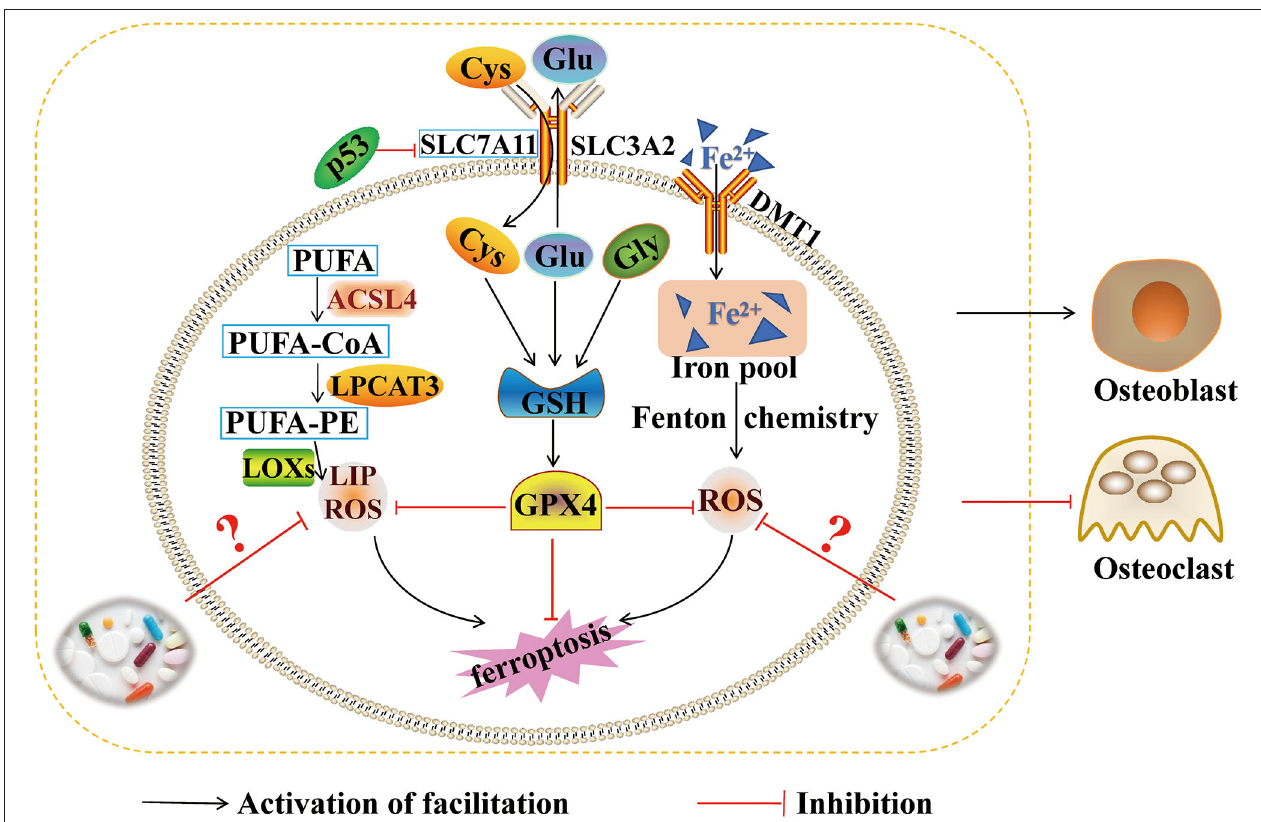
FIGURE 4 | Ferroptosis and bone formation. This figure summarizes the molecular mechanism of ferroptosis and the regulatory effect of ferroptosis on bone formation. The black arrow represents the activation of the regulatory role of ferroptosis. The red inhibition arrow represents the inhibition of the regulatory role of ferroptosis and